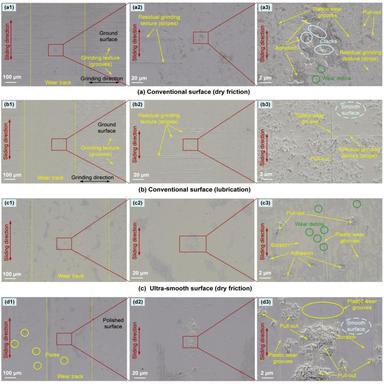
SEM morphology images of the wear track and the local details under different conditions.